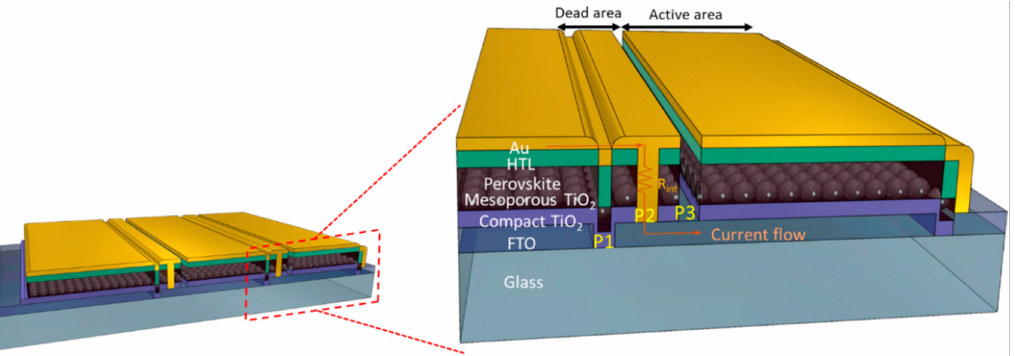
Figure 1. The schematics of the cross-section of the serial interconnect region (P1-P2-P3) of a